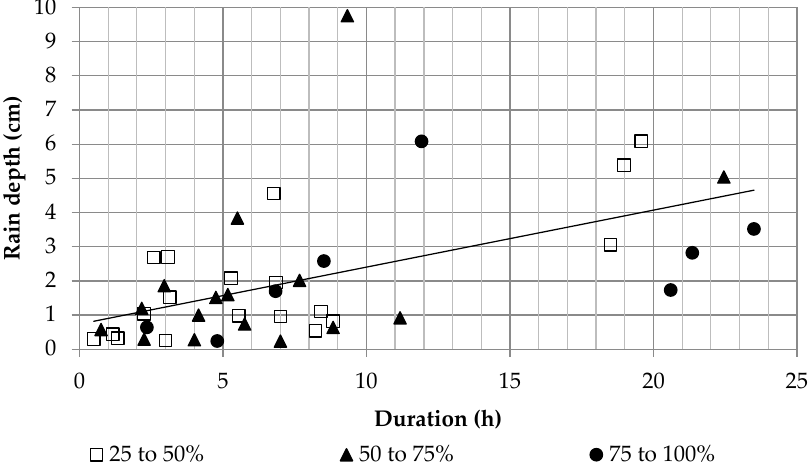
Figure 4. Correlation of rainfall depth and duration with percentage of infiltration in the swale.